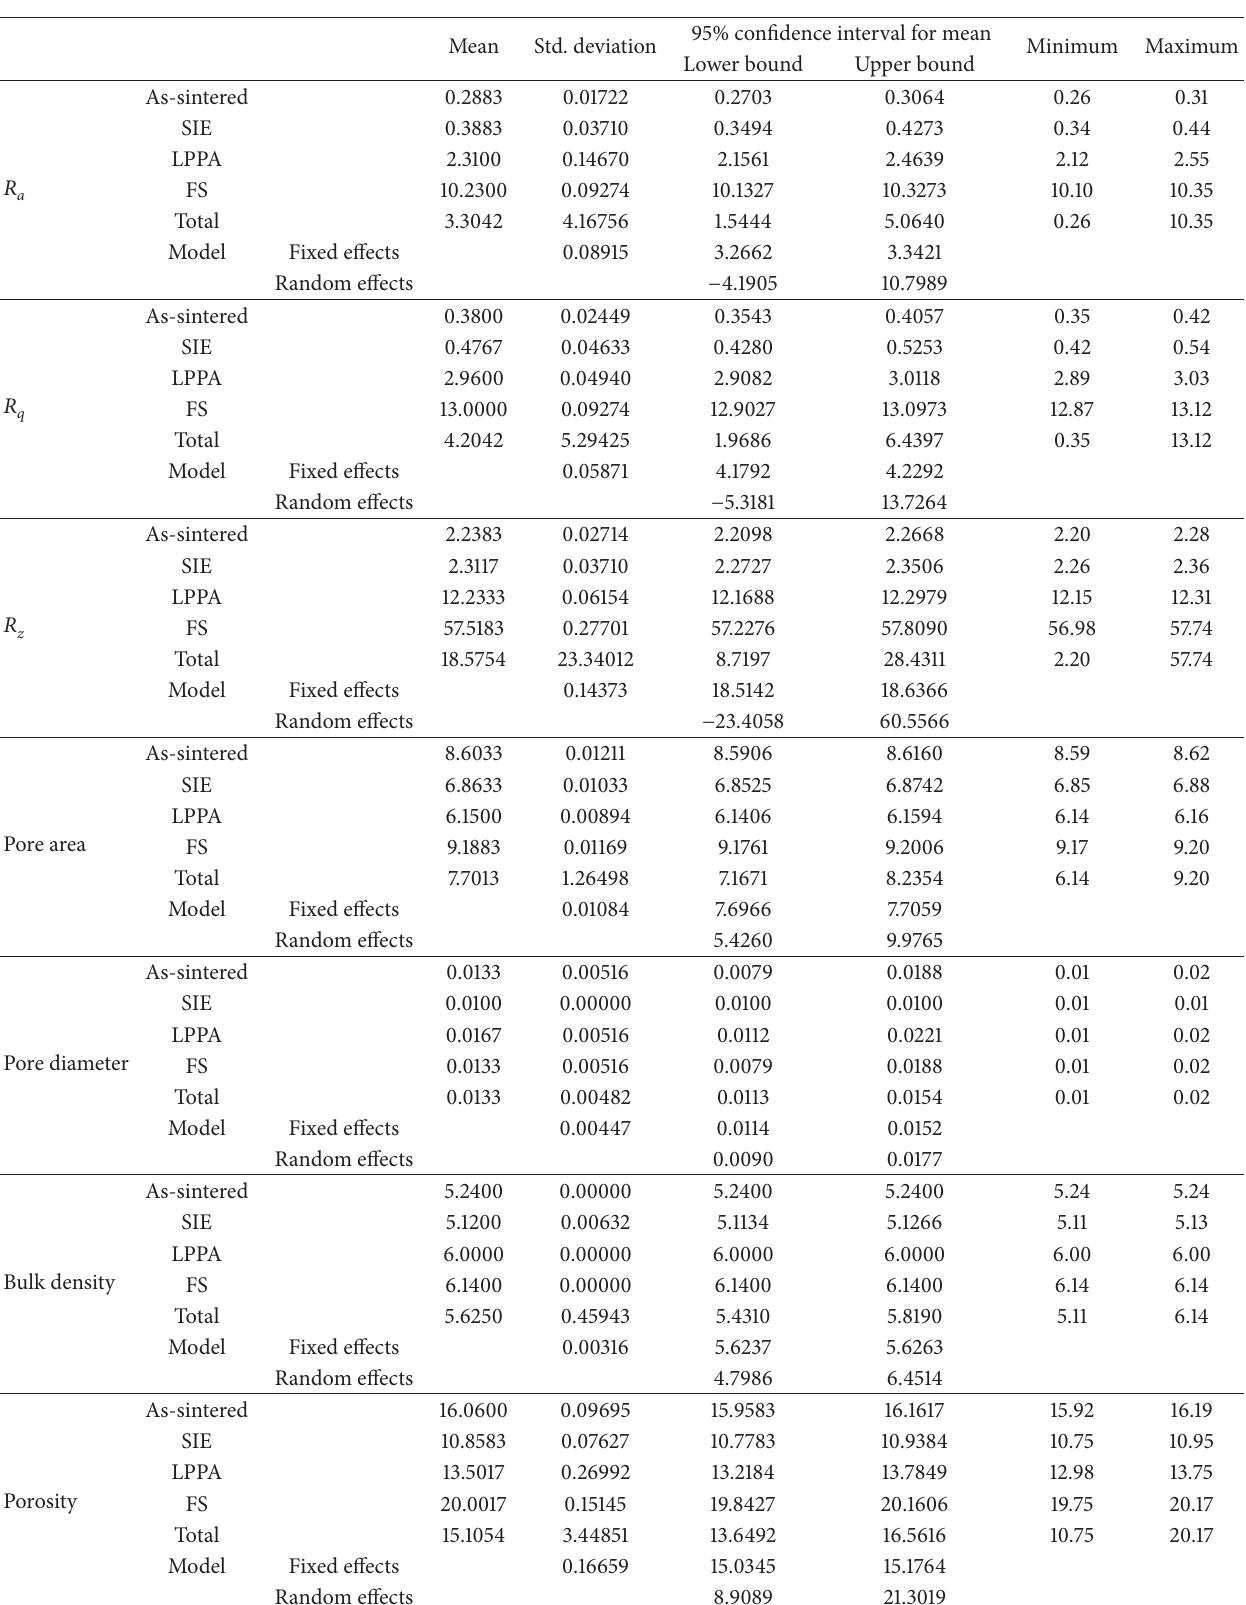
Table 1: Surface parameters of different test